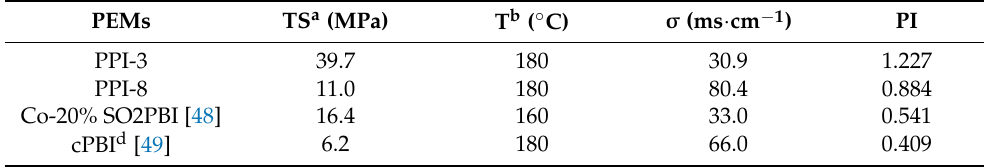
Table 3. PPI values of various PA ‐ doped PPI membranes.